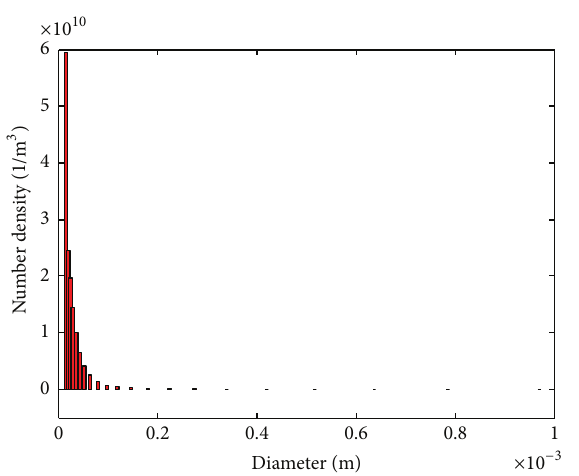
Figure 18: Plot of the number density of bubble in a plane near to the gas inlet for nozzle 1.